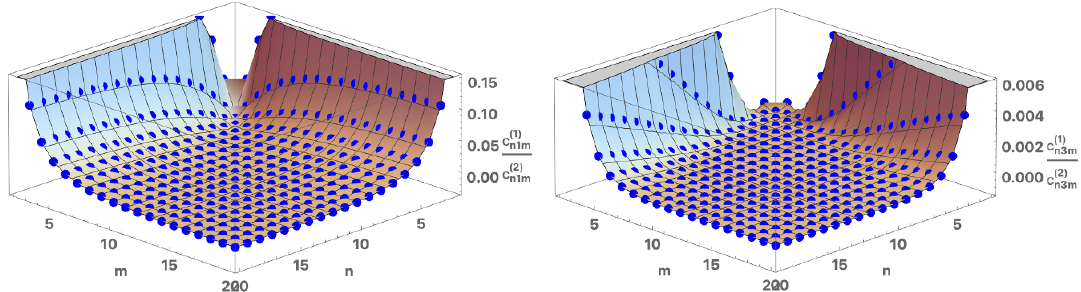
Figure 4 . Left: diagonal values of the OPE coe(cid:14)cients m; n k . Right: diagonal values of the OPE coe(cid:14)cients c (2) (cid:29) m; n k , thereby demonstrating the dominance of contact diagrams over the planar diagrams in (cid:29) this limit. Note that the y-axis of the right (cid:12)gure is plotted on a logarithmic scale.